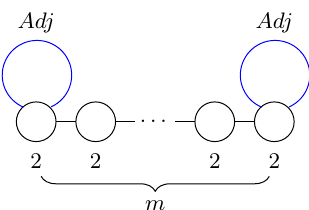
Figure 16 . Coulomb branch quiver with A m global symmetry, dim M H